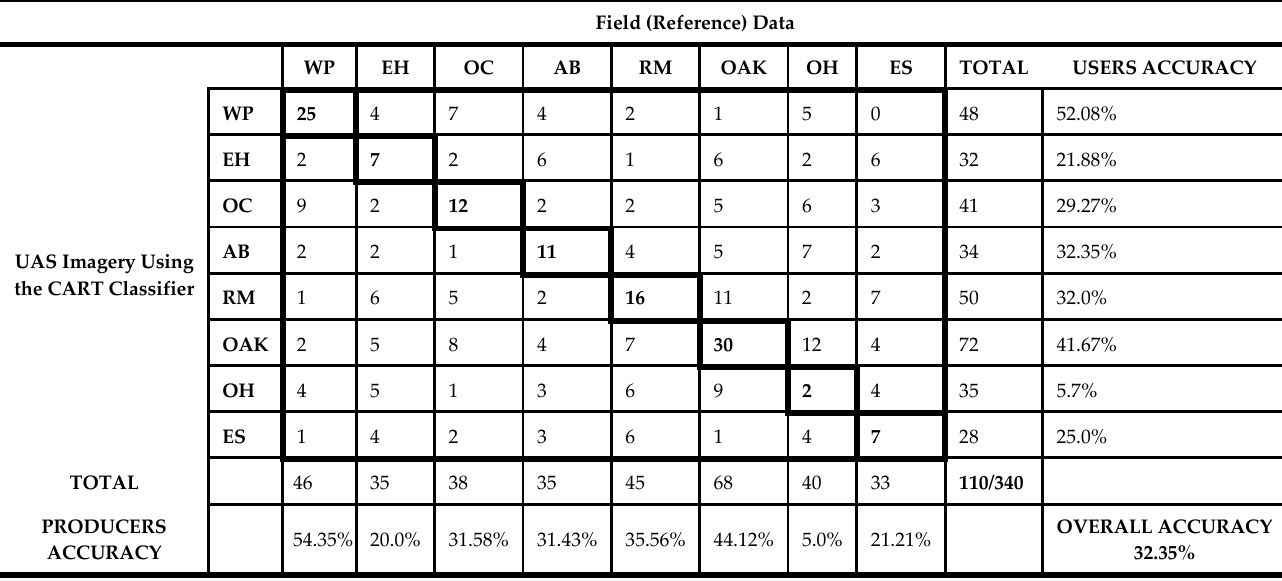
Table A3. Thematic map accuracy assessment error matrix for individual trees using the UAS imagery and the CART algorithm for eight classes.